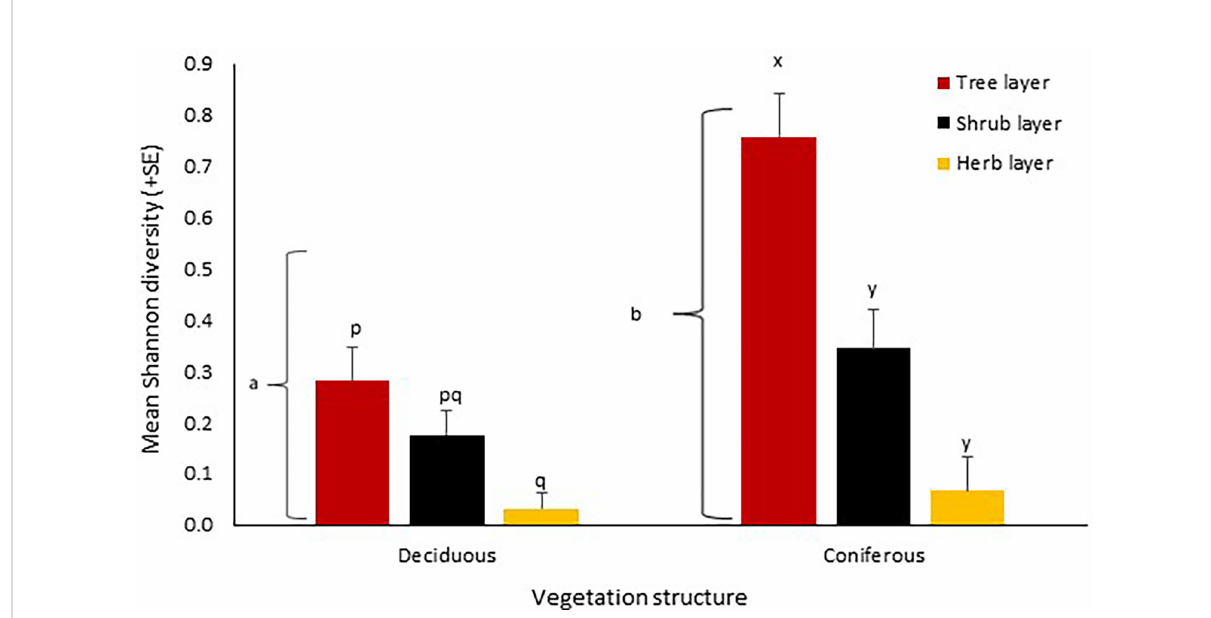
FIGURE 3 Mean Shannon diversity (+SE) of native coccinellid species at deciduous and coniferous sites and at different vegetation layers across all sites in Cambridgeshire and Suffolk. Consecutive letters indicate where signi fi cant differences occur. Letters on brackets represent differences between deciduous and coniferous sites